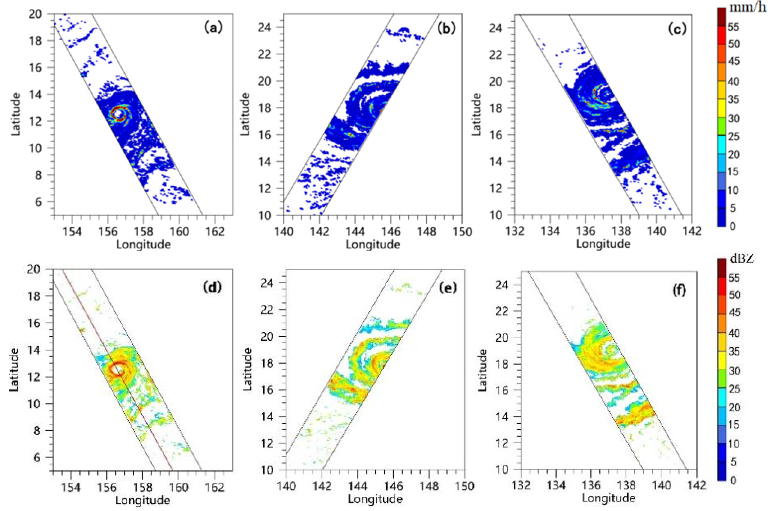
Figure 3. Distributions of ( a – c ) precipitation intensity (mm·h − 1 ) and ( d – f ) radar reflectivity (dBZ) of Typhoon Nangka detected by the GPM at ( a , d ) 17:00 on 6th July, ( b , e ) 06:00 on 9th July and ( c , f ) 16:00 on 12th July.